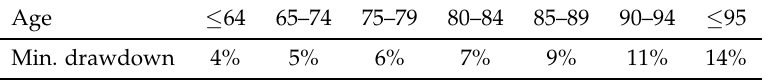
Table 3. Minimum regulatory withdrawal rates for Allocated Pension accounts for the year 2017 and onwards